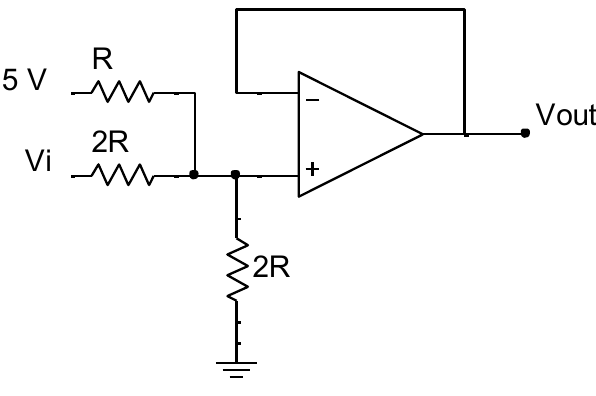
Fig. 12. Signal conditioning circuit for input and output shaft